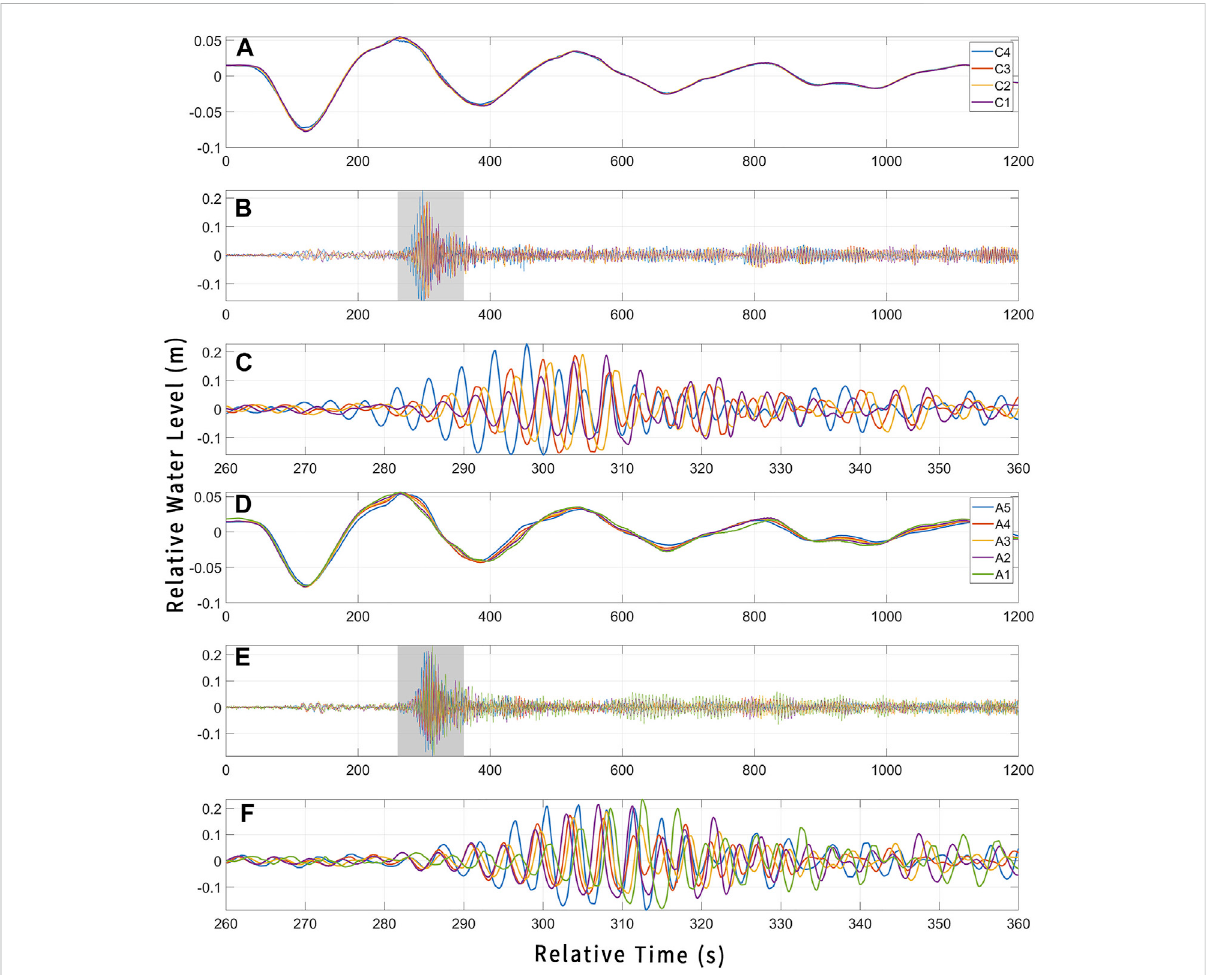
FIGURE 9 Propagation of a sample southbound wake event through the installation, where (A – C) show the cross-shore sensor array and (D – F) show the alongshore sensor array. (A) and (D) are the low-frequency signal; (B) and (E) are the high-frequency signal; and (C) and (F) are the high-frequency signal contained in the shaded area in (B) and (E) ,